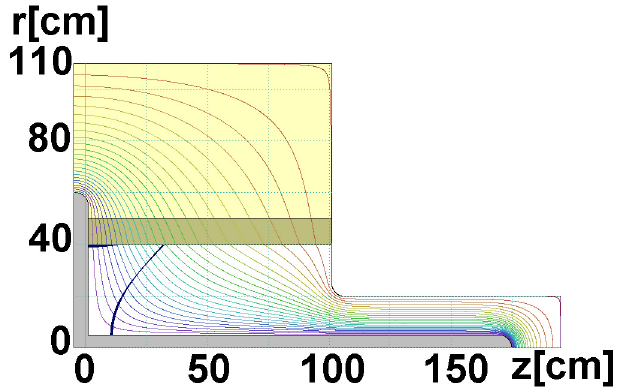
FIG. 4. (Color) Equipotential curves at the front end of a typical pulsed-power machine (half cross section of the axially sym- metric structure is drawn). Low current electrons are emitted at two ‘‘weak’’ points: at the cathode triple junction and along the central stalk. Parts are colored as in Fig.